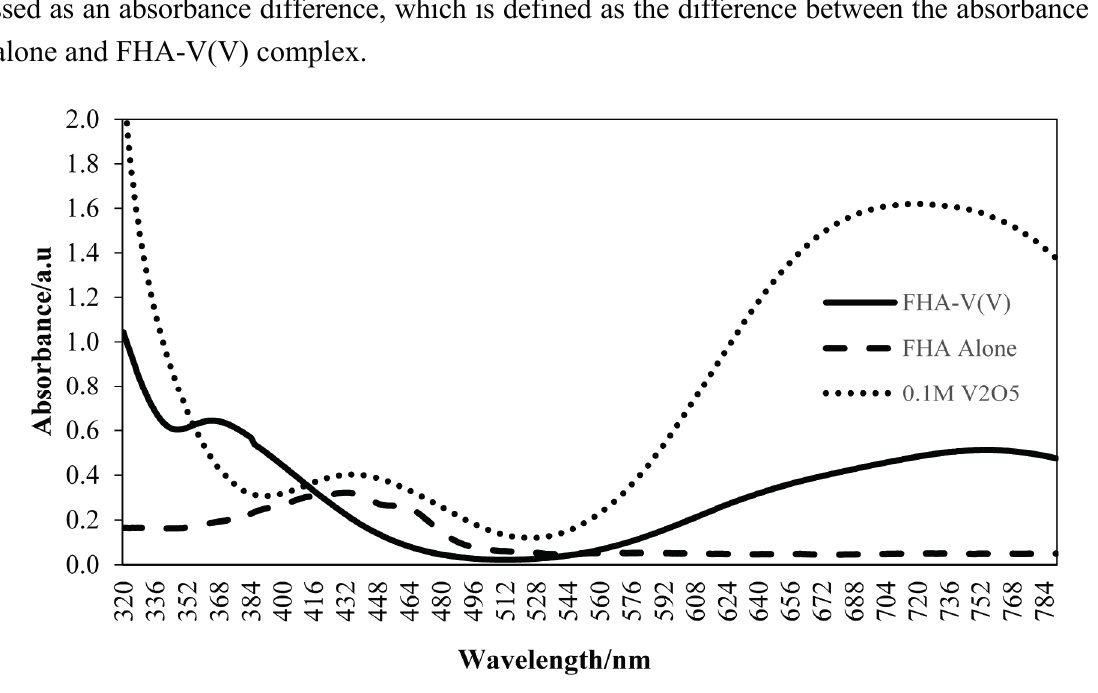
Figure 1. Absorbance spectra for aminolysis of FHA at 60 min of complexation with V(V) ion